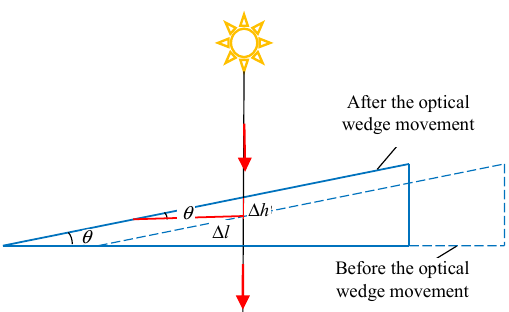
Fig. 3 Basic structure of the designed interferometer.